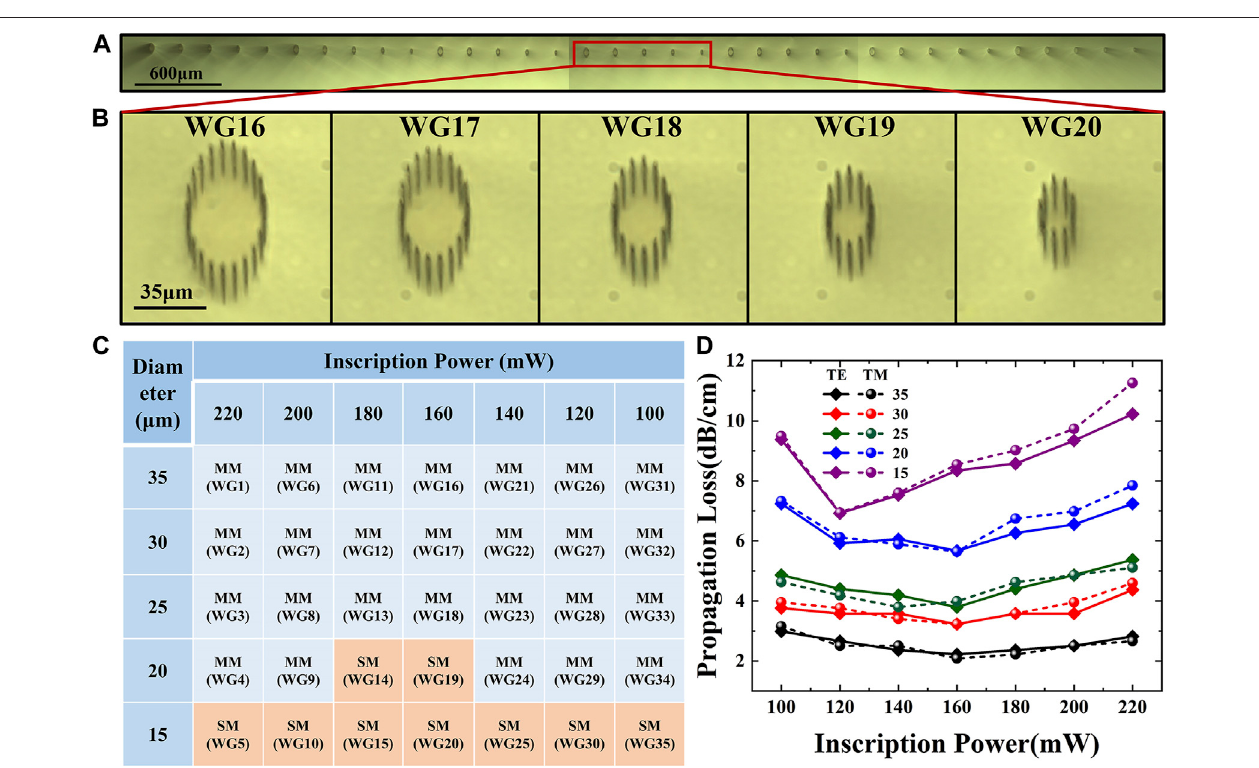
FIGURE1|(A) Theend-facemicroscopeimagesofcladdingwaveguidesinPr:LuAG. (B) EnlargedimagesofWG16-WG20. (C) Modepro fi lesobservedfromall35 waveguides; MM and SM represent multi-mode and single-mode, respectively. Single-mode wavegudies are highlighted in orange. (D) Propagation losses of the cladding waveguides at 633 nm under TE and TM